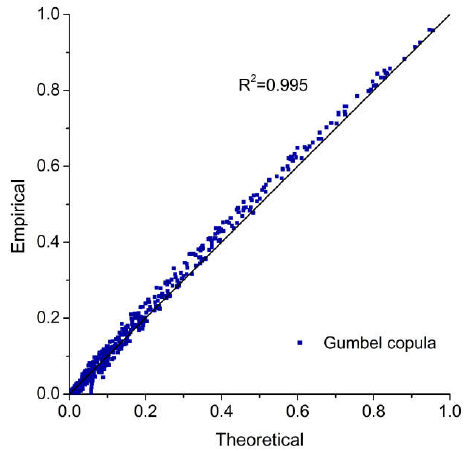
Figure 8. P–P plot of the joint distribution of typhoons, rainfall, and storm surges. Int. J. Environ. Res. Public Health 2018 , 15 , x